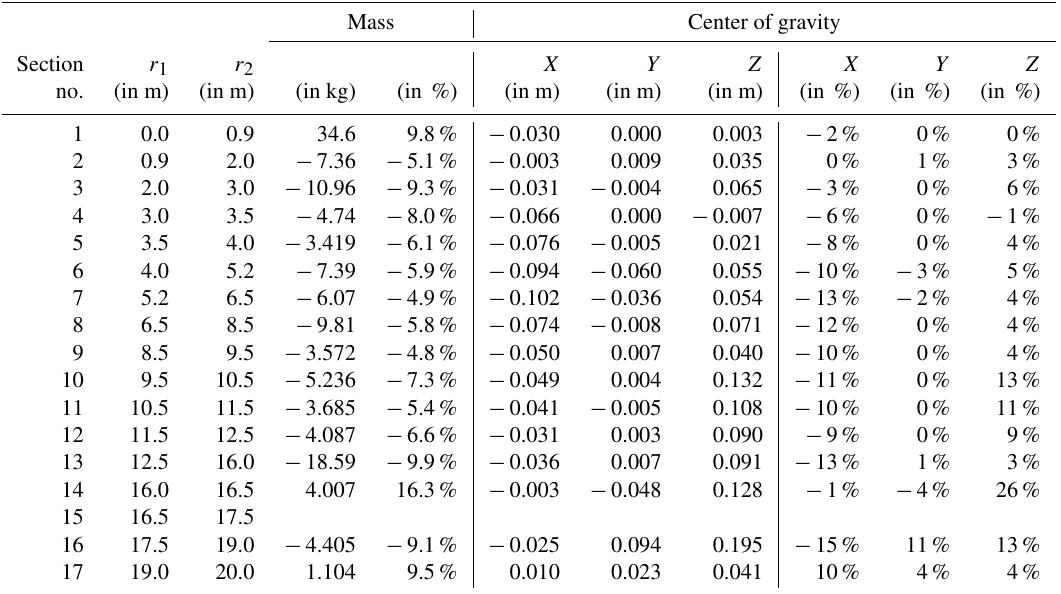
Table 3. Segment mass and center of gravity (CoG) differences between experiment and simulation. The relative distances of the CoG are given with respect to their corresponding geometrical cross-section parameter, i.e., absolute thickness ( X ), chord length ( Y ), and spanwise segment length ( Z